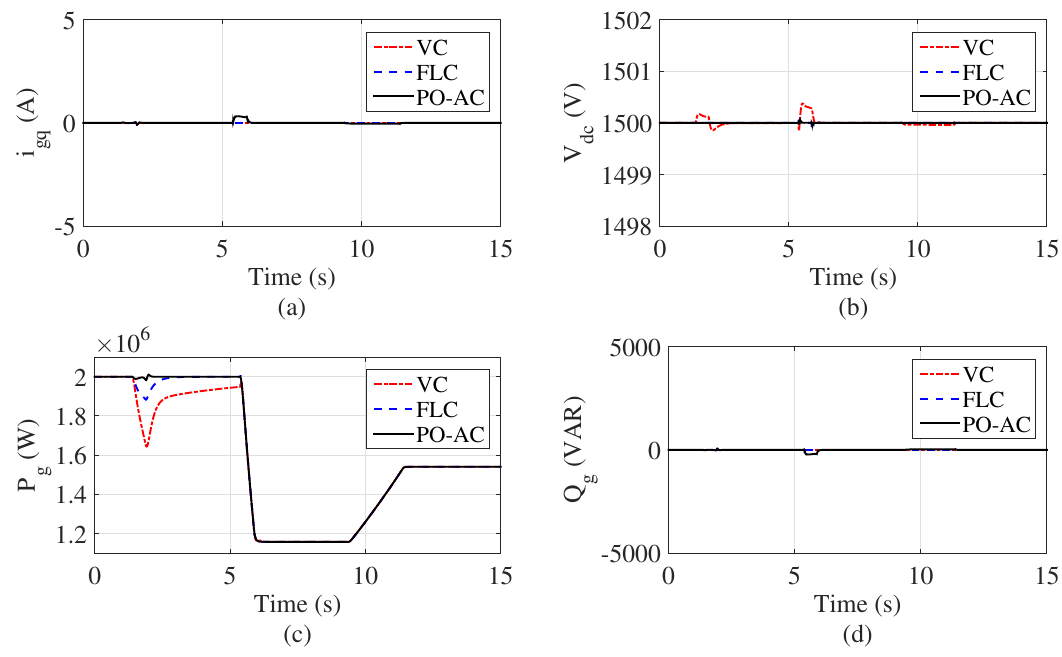
Figure 6. Responses of the grid to ramp wind speed. ( a ) q-axis current i gq . ( b ) DC-Link voltage V dc . ( c ) Active power of grid P g . ( d ) Reactive power of grid Q g .